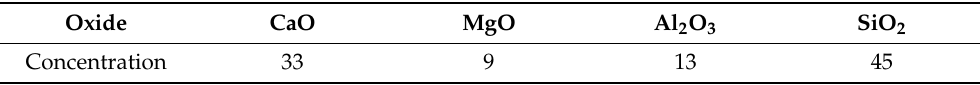
Table 2. Chemical composition of the CMAS system; the values are given in mol%